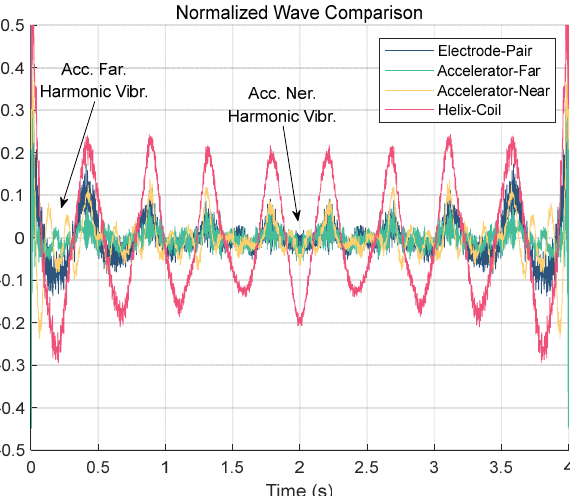
Figure 11. Received time domain signal normalizations from the improved experimental section.